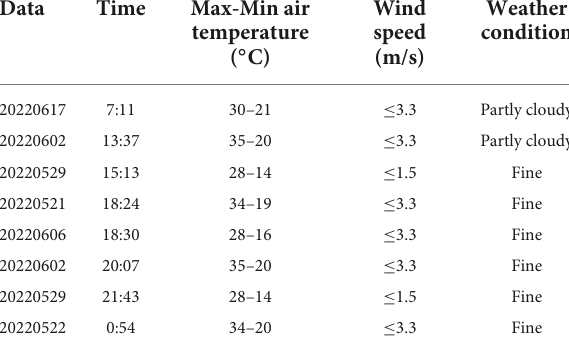
TABLE 1 The time of ECOSTRESS 2B-LST data, and their corresponding weather